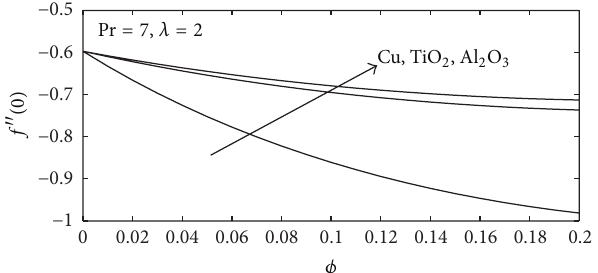
Figure 8: Variation of 𝑓 󸀠󸀠 (0) with 𝜙 for different types of nanopar- ticles when Pr = 7 and 𝜆 = 2 .